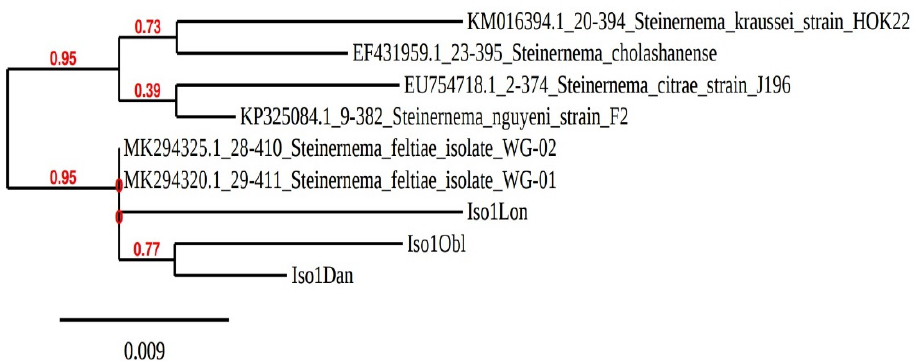
Figure 1. Agarose gel electrophoresis of internal transcribed spacer (ITS) PCR products from four Steinernema feltiae isolates: Lane 1: 100 bp DNA Ladder; Lane 2: PCR product of control sample ( S. feltiae from biopreparation); Lane 3: PCR product of iso1Lon; Lane 4: PCR product of iso1Dan; Lane 5: PCR product of iso1Obl.